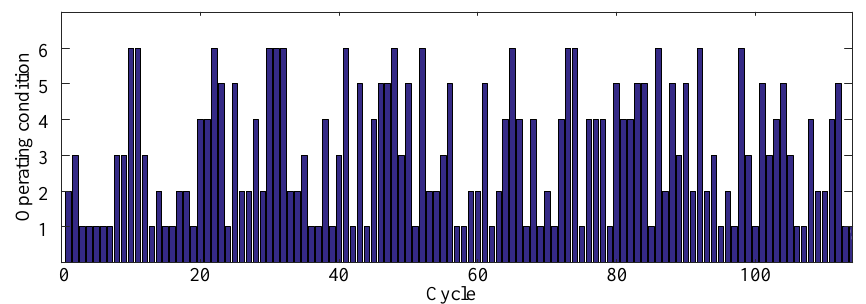
Table 5. The predicted life of each operating condition by similarity trajectory method (STM).